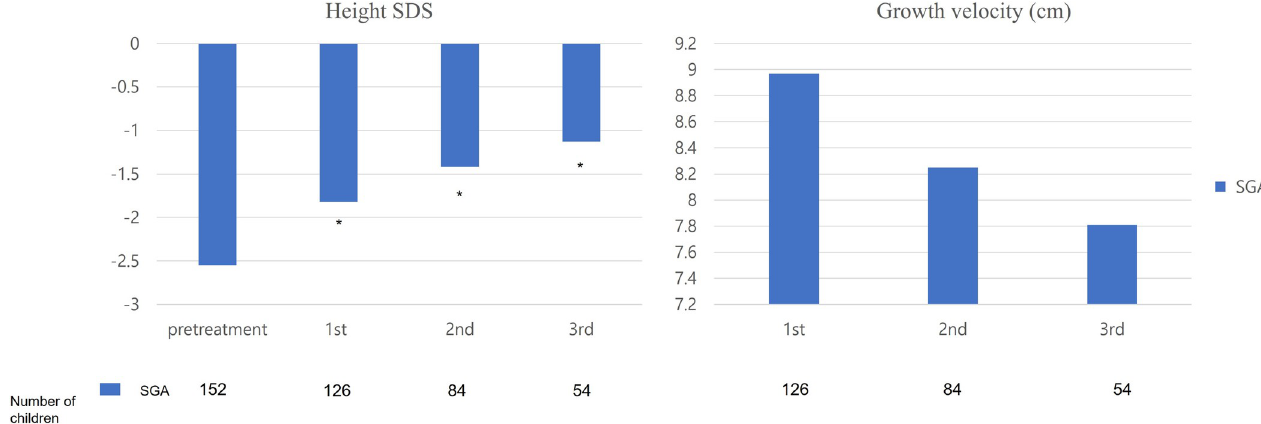
Fig 2. Change in height SDS and growth velocity before and after treatment with GH in children with SGA. � P < 0.001 compared with before growth hormone treatment. Abbreviations: GH, growth hormone; SGA, small for gestational age.